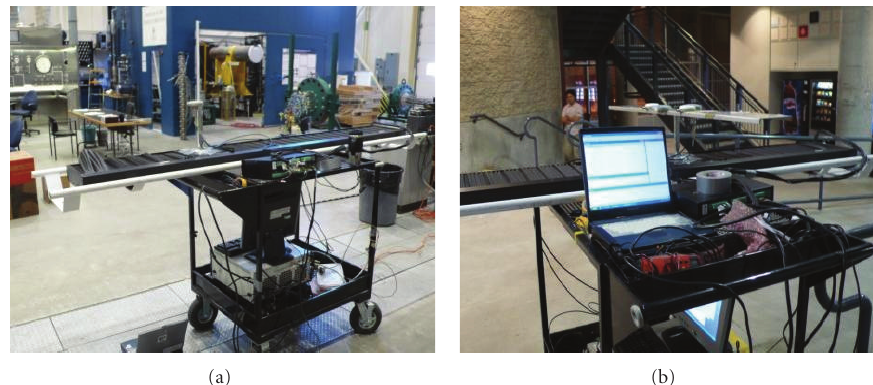
Figure 7: Data collection sites in indoor locations (a) Energy High Bay (b) corridor.